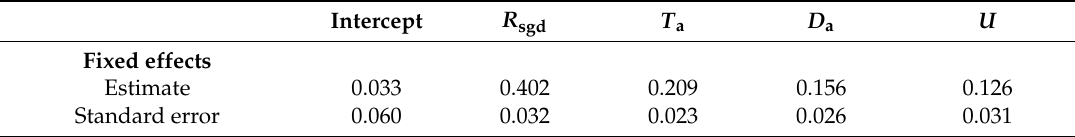
Table 2. Fixed and random effects for parameters in the linear mixed effects model of daily pan evaporation measurements. The marginal coefficient of determination (i.e., without application of the random effects) was R 2 =